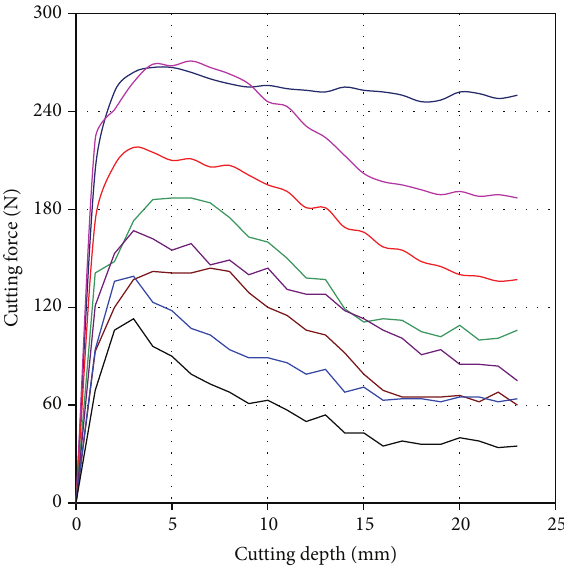
Figure 3: Relationship between cutting force and cutting